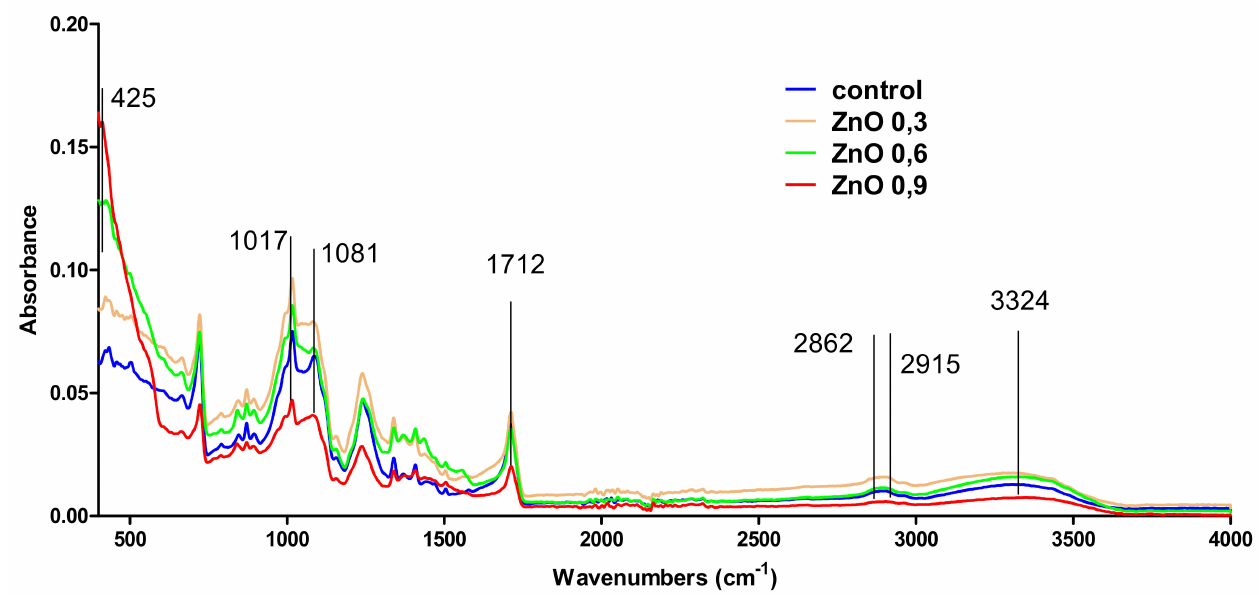
Figure 3. FT-IR spectra for control and for the ZnO NPs-coated dressings (ZnO 0.3; 0.6; 0.9%) and